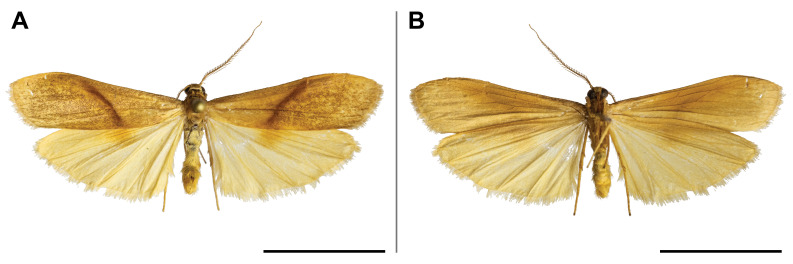
Ligulosia
costimaculata (Aurivillius, 1910). A. dorsal view; B. ventral view. The scale bar represents 1 cm.